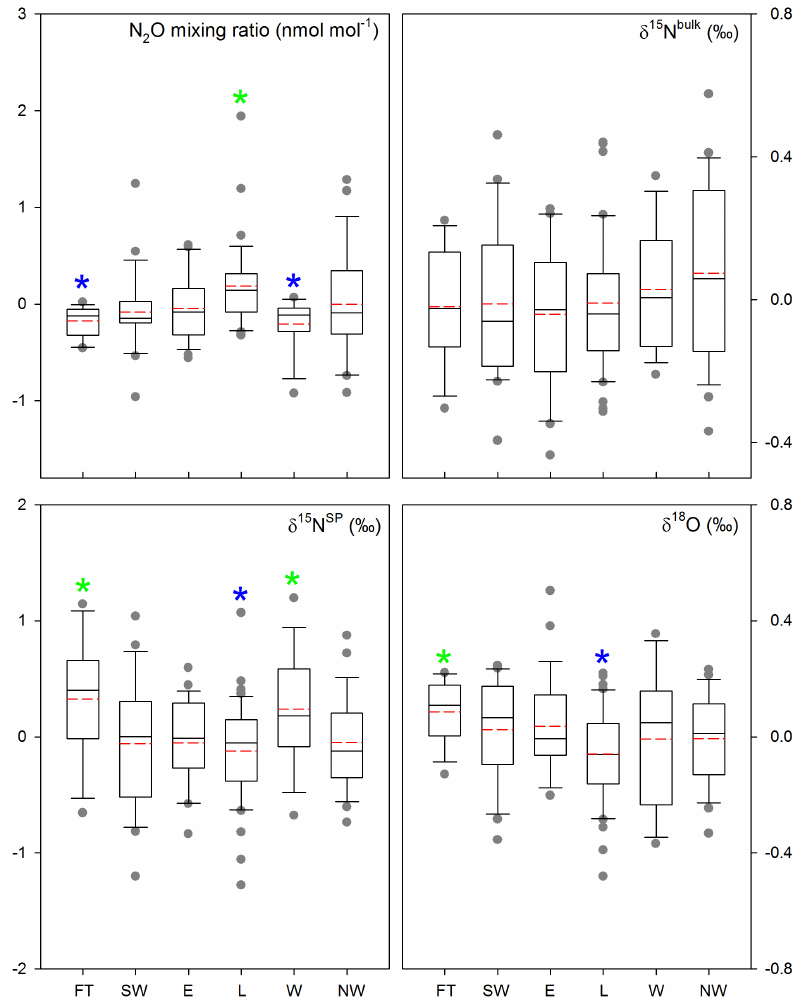
Figure 6. Comparison of N 2 O mixing ratios and isotopic signatures (with linear trends removed) for the six air mass footprint clusters used in the present study. Green and blue stars indicate significantly larger and smaller values than the others, respectively; red dashed lines indicate mean levels; grey points indicate